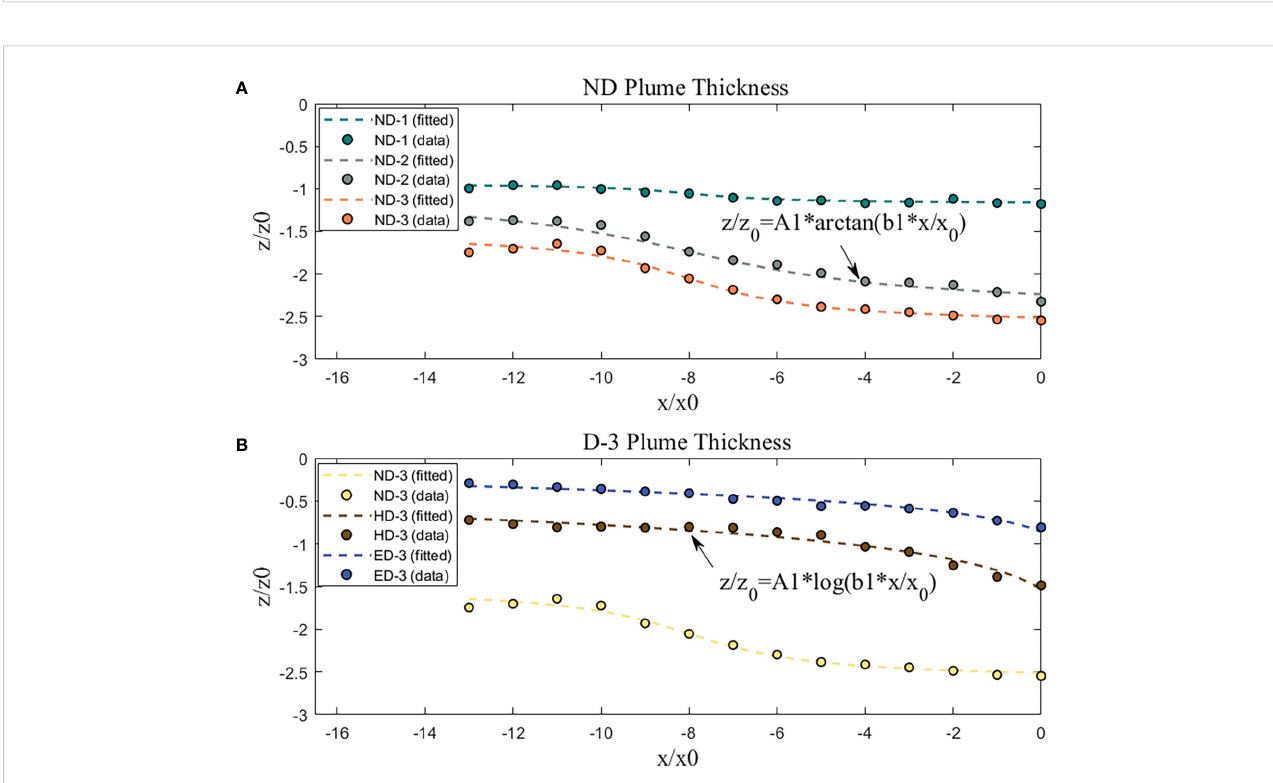
FIGURE 7 Thickness of river plume in different cases: ND group (A) and D3 group (B)